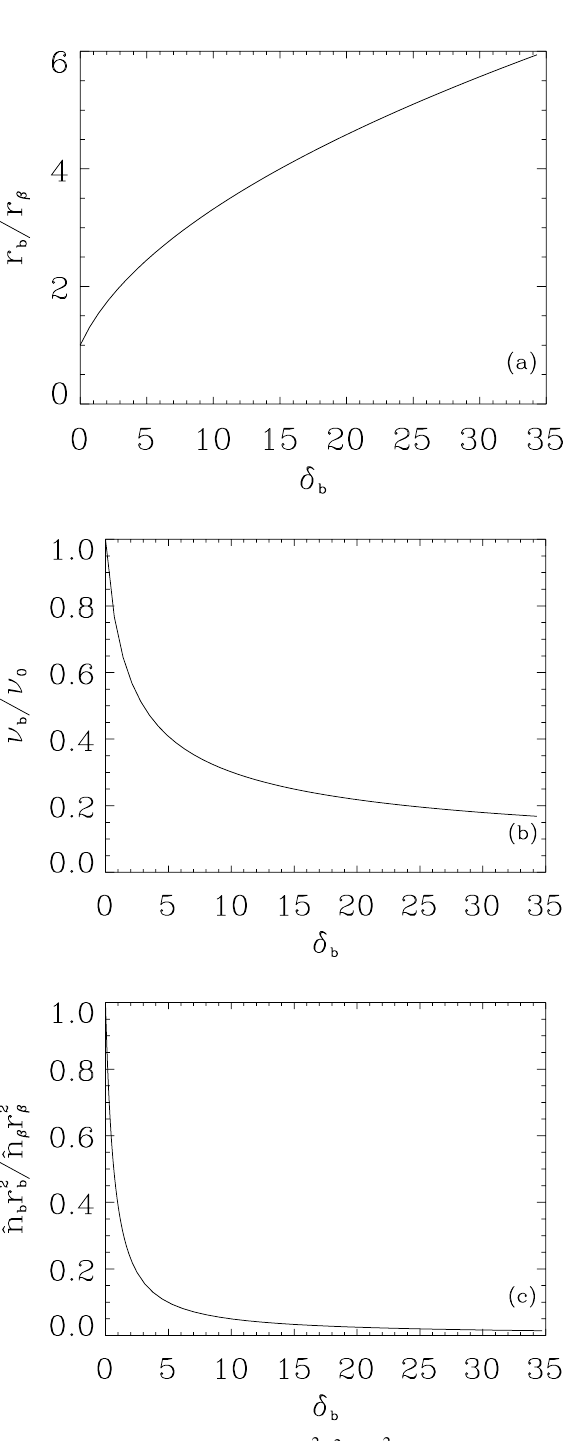
FIG. 2. Plot versus d b (cid:1) N b Z 2 b e 2 (cid:3) 2 g 2 b T b of (a) r b (cid:3) r b [Eq. (13)], (b) n b (cid:3) n 0 [Eq. (16)], and (c) ˆ n b r 2 b (cid:3) ˆ n b r 2 b [Eq.